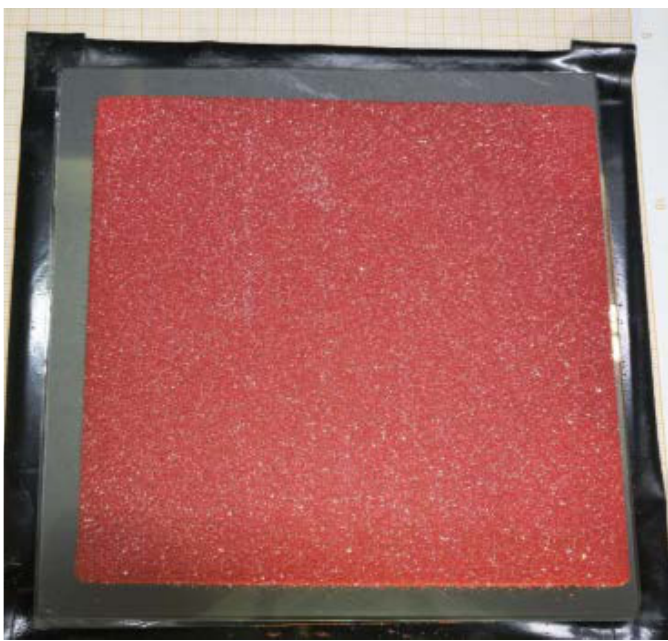
Figure 2. HgI 2 -coated 13 × 13 cm 2 on ITO.